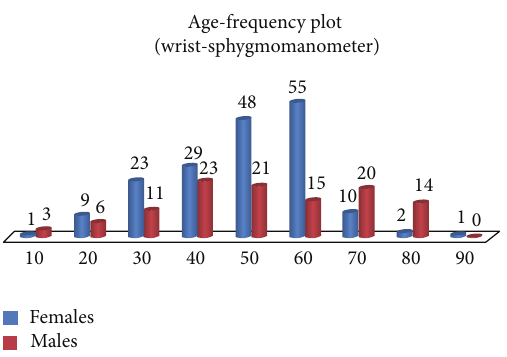
Figure 5: Age and frequency of subjects under